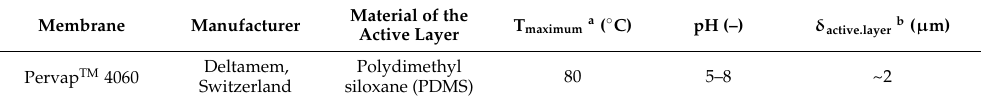
Table 1. Main characteristics of the pervaporation membrane used in this work (information provided by the manufacturer).